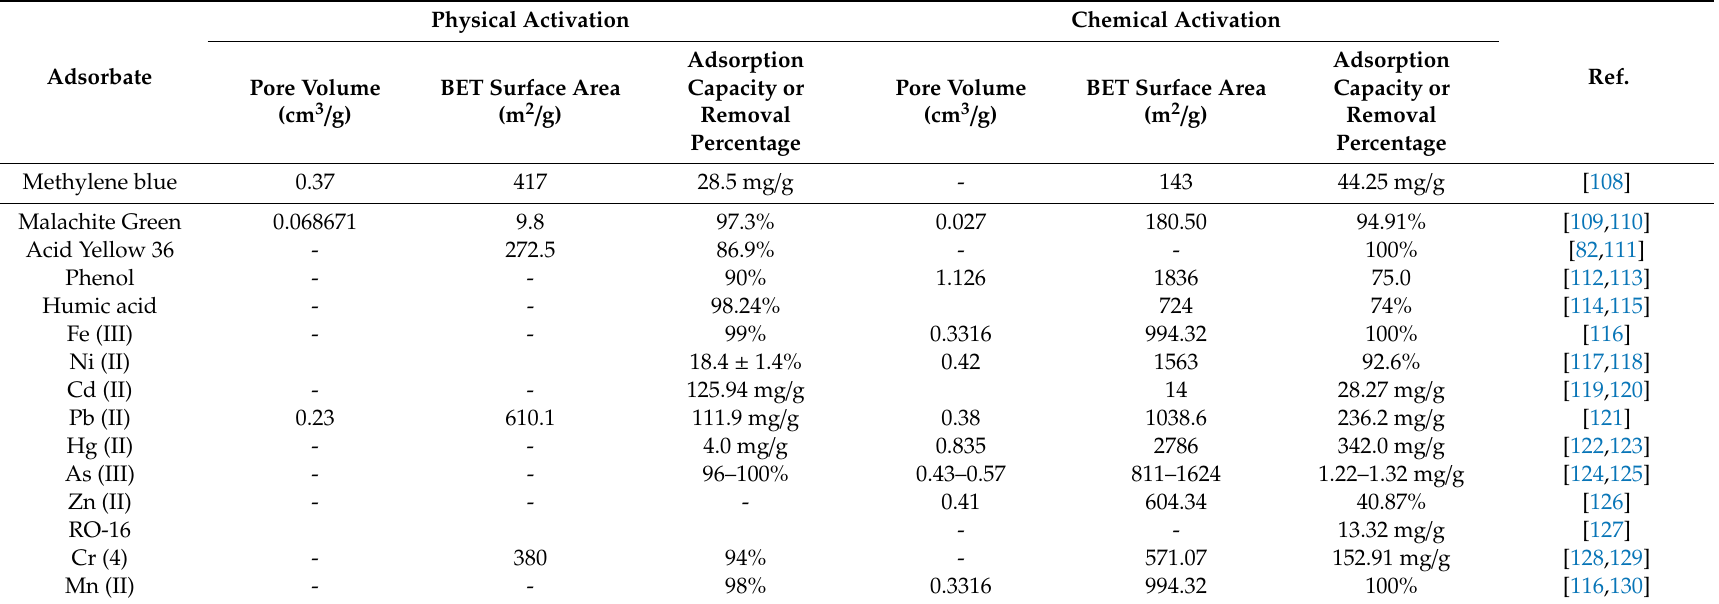
Table 5. Adsorption performance of physically and chemically activated RH-derived